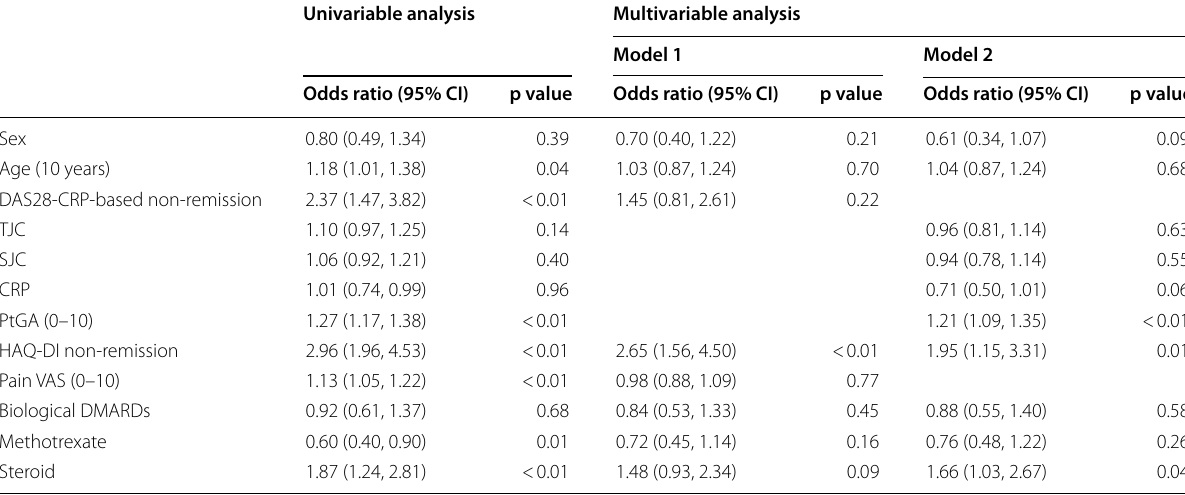
CI confidence interval, DAS28 Disease Activity Score in 28 joints, CRP C-reactive protein, TJC tender joint count, SJC swollen joint count, PtGA patient global assessment, HAQ-DI Health Assessment Questionnaire Disability Index, VAS Visual Analogue Scale, DMARDs biological disease-modifying anti-rheumatic